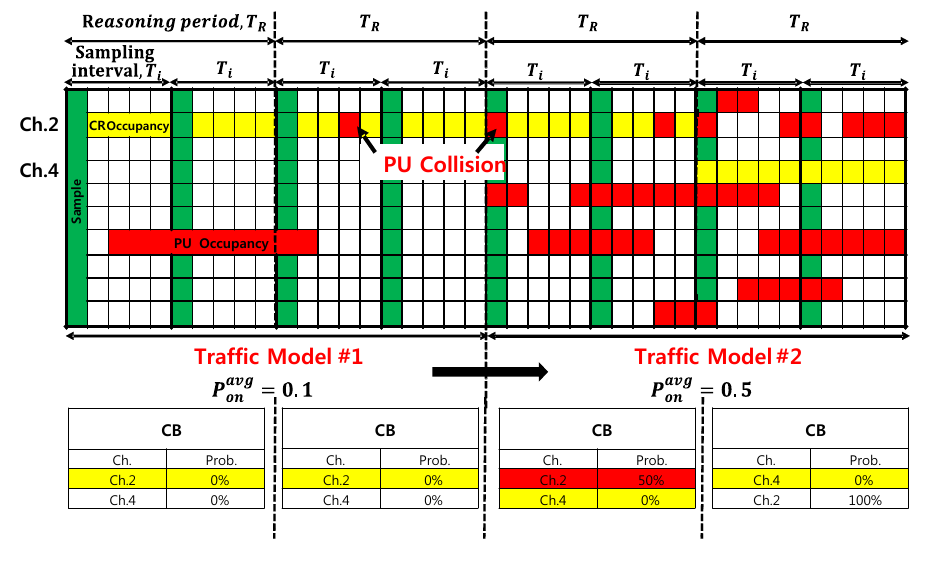
Figure 10. Definition of collision and an example of a periodic operation of the CR